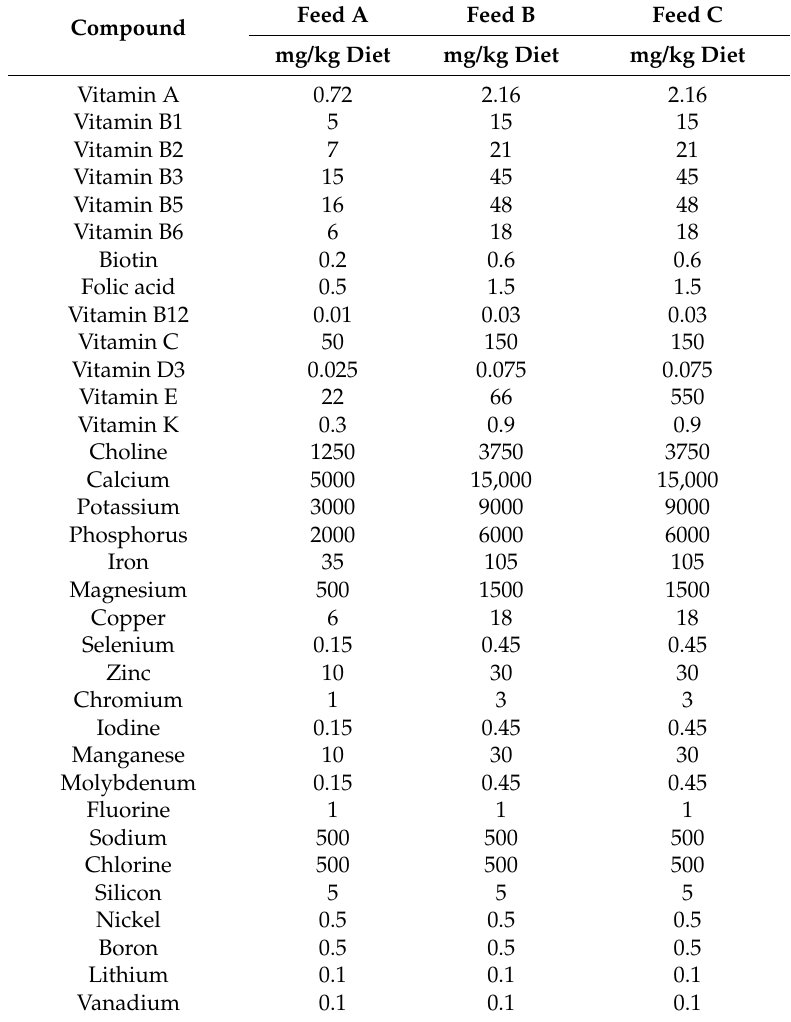
Table 1. Composition of the different feeds with respect to vitamins and